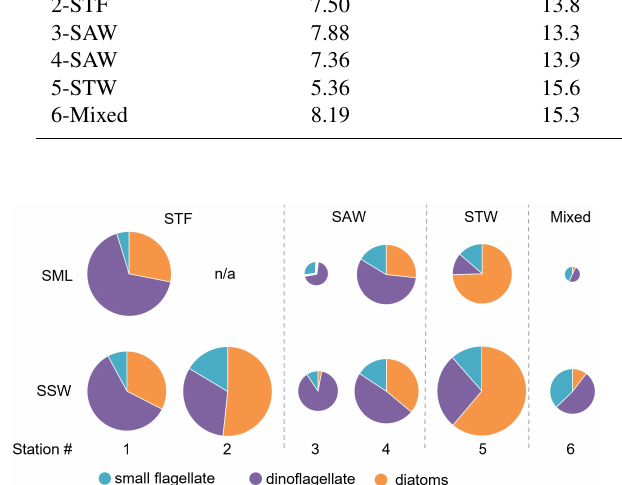
Figure 7. Pie charts showing the relative variation of diatoms, di- noflagellate, and small flagellates in the sea surface microlayer (SML) and subsurface water (SSW). The size of the pie is propor- tional to the total carbon content of phytoplankton > 5µm. Water mass type is indicated by the label at the top of the figure and sep- arated by the grey vertical dashed lines. There are no data for SML 2-STF as the sample was not